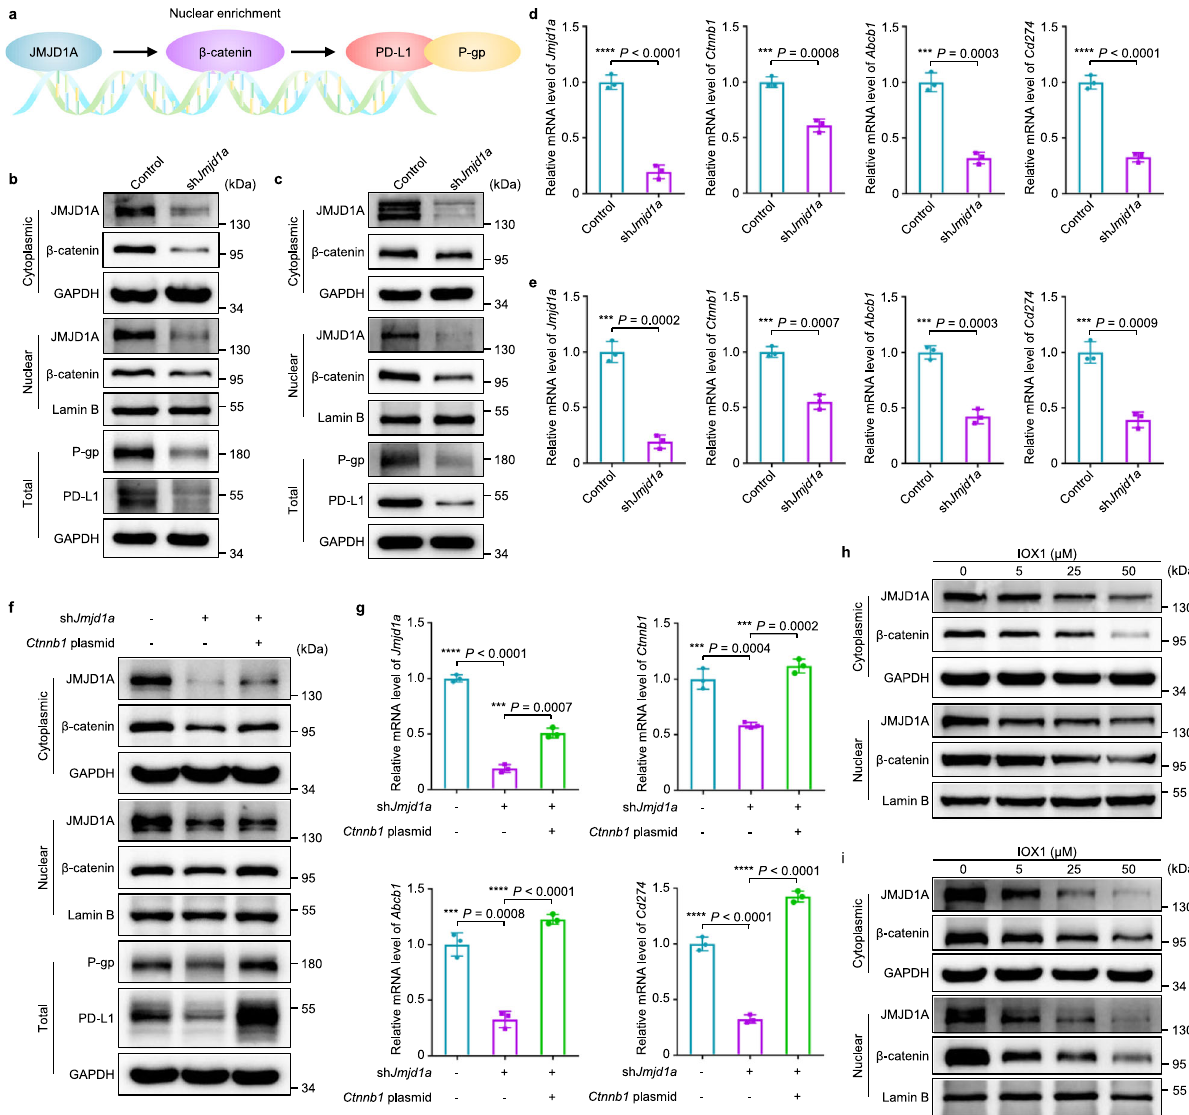
Fig. 4 IOX1 downregulates P-gp and PD-L1 expression through JMJD1A/ β -catenin signaling pathway. a The pathway by which JMJD1A promotes P-gp and PD-L1 expression in tumour cells. The overexpressed JMJD1A increases the nuclear enrichment of β -catenin, which in turn accelerates the transcription and translation of downstream targets, including P-gp and PD-L1. b – e Effects of JMJD1A-knockdown on protein expressions measured by western blotting ( b , c ) or gene expressions measured by qPCR ( d , e ) in CT26 ( b , d ) or HCT116 ( c , e ) cells; 4 × 10 5 cells were transfected with sh Jmjd1a (2 μ g/well) for 48 h; n = 3 independent experiments in ( d , e ). f , g Effects of β -catenin rescue in JMJD1A-knockdown CT26 cells on the P-gp and PD-L1 expressions: ( f ) the relative protein levels and ( g ) mRNA levels of JMJD1A ( Jmjd1a ), β -catenin ( Ctnnb1 ), P-gp ( Abcb1 ) and PD-L1 ( Cd274 ) in CT26 cells; 4 × 10 5 cells were transfected with sh Jmjd1a (2 μ g/well) for 48 h followed by transfection with Ctnnb1 plasmid (2 μ g/well) for 24 h; n = 3 independent experiments in ( g ). h , i IOX1 dose-dependent reduction of JMJD1A and β -catenin protein levels in CT26 ( h ) and HCT116 ( i ) cells; 24 h treatment. In ( b , c , f , h , i ), the experiments were repeated independently three times to con fi rm the results. Data represent mean ± SD. Two-tailed Student ’ s t test. *** P < 0.001, **** P < 0.0001. Source data are provided as a Source Data fi